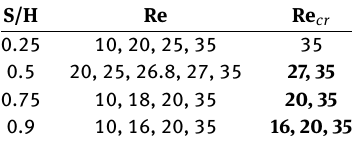
Table 1: Critical Reynolds number in different S/H for three jets